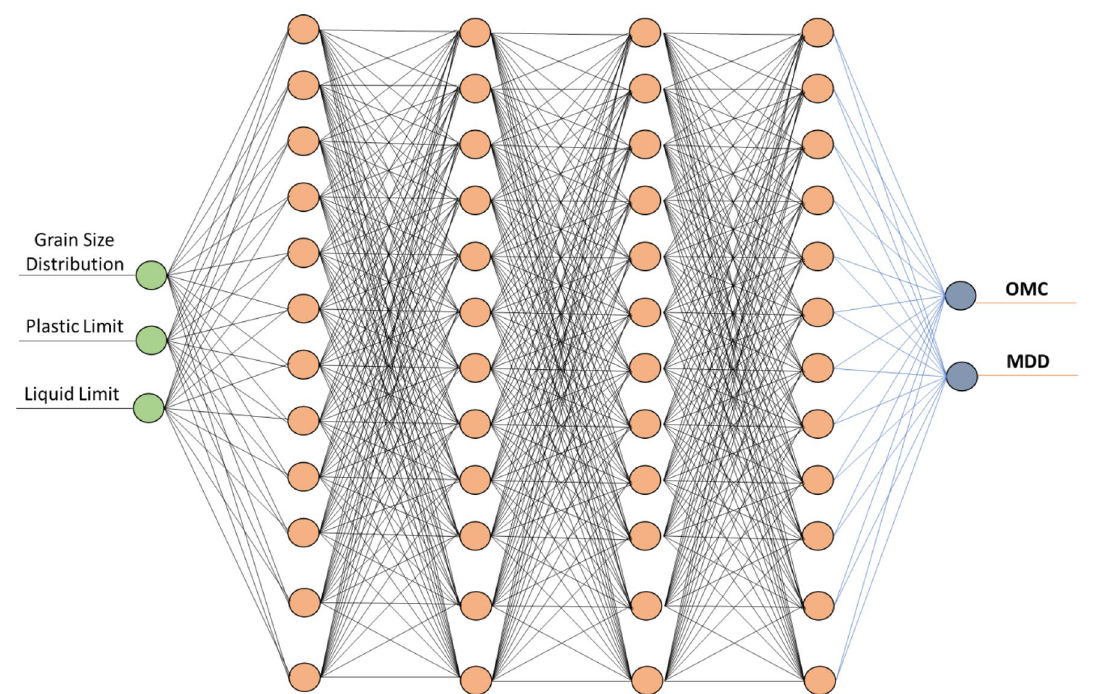
Fig. 6 The optimum ANN that produces the best OMC and MDD